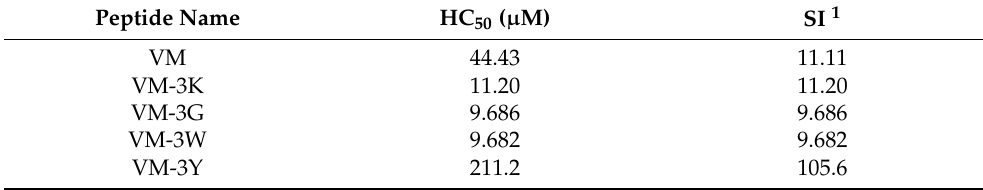
Figure 4. Haemolytic activity of peptides to horse erythrocytes. The haemolytic activities are presented as percentages normalised to a positive control (100% haemolysis caused by 1% Triton X-100). The horse red blood cells incubated with PBS were used as the negative control. Data points represent mean ± SEM of nine replicates from three independent experiments. The statistical significance was analysed using two-way ANOVA with Dunnett’s multiple comparisons test in GraphPad Prism software by comparison with the negative control (* p < 0.05, ** p < 0.01, *** p < 0.001, **** p < 0.0001). (i) shows the MIC concentration of VM-3K, VM-3G and VM-3W; (ii) shows the MIC concentration of VM-3Y; and (iii) shows the MIC concentration of VM. Table 6. The peptide concentrations that caused 50% lysis of horse red blood cells. (HC 50 , µ